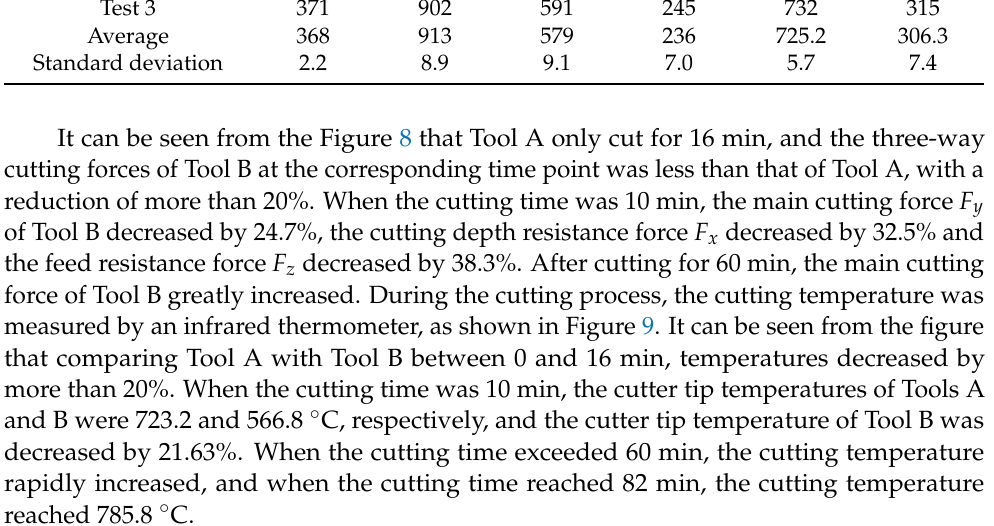
Figure 9. ( a ) Temperature change around the tool A tip. ( b ) Temperature change around the Tool B tip. The friction coefficient, shear energy and sliding energy of Tool A and Tool B in the cutting process were calculated by measuring the cutting force in the three directions of the tool combined with the tool parameters in Table 1 and Equations (1)–(9). As shown in Figure 10a,b, during the cutting process, the friction coefficient of the cutting chip of Tool B was always lower than that of Tool A. The maximum friction coefficient of Tool B was 0.685, and the lowest friction coefficient of Tool A was 0.722. It can be seen from Figure 11a–d that when the cutting time was from 2 min to 16 min, the shear energy of Tool A was from 3785.2 to 5266.3 MJ/m 3 ; at the same time frame, the shear energy of Tool B was greatly decreased. The sliding energy of Tool A was increased from 1009.9 to 1193.4 MJ/m 3 , and the friction energy of Tool B was decreased by more than 40% at the same moment. It can be seen from Figure 8 that the three-dimensional cutting forces of Tool B were greatly reduced compared to Tool A, and the inputs of shear energy and sliding energy of Tool B were less. 0